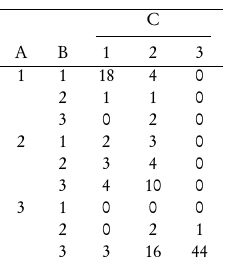
Independent classification by three pathologists of most involved histological